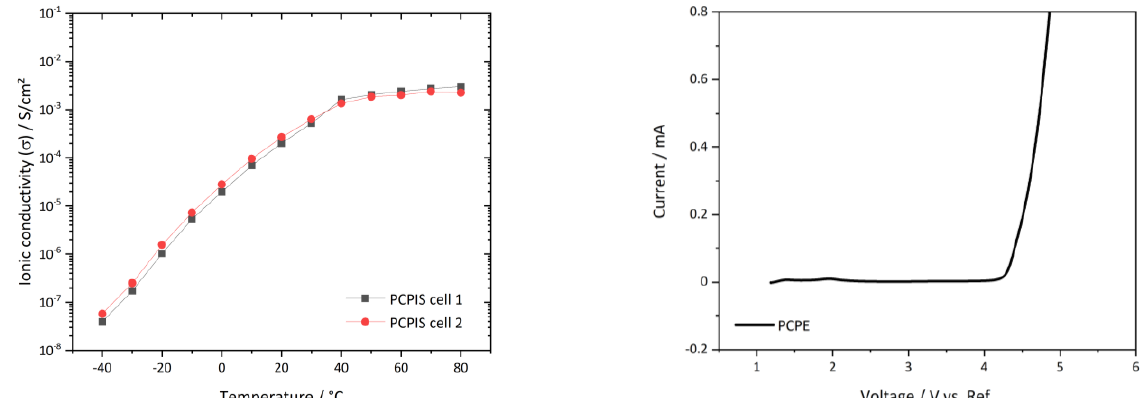
Figure 3. ( Left ): Arrhenius graph derived from impedance spectroscopy of PCPE infiltrated separator (PCPIS) between −40 °C and 80 °C vs. steel electrode; ( Right ): Linear voltage sweep of PCPIS vs. lithiated graphite with 1 mVs -1 ; here shown a representative curve of three measured cells.